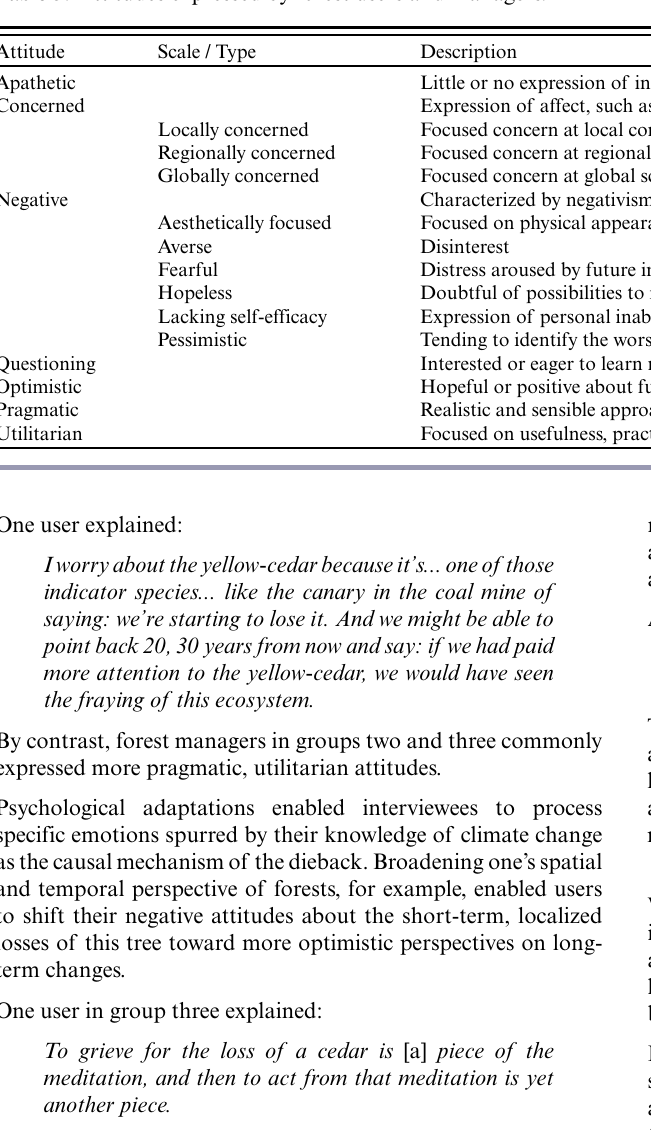
Table 3 . Attitudes expressed by forest users and